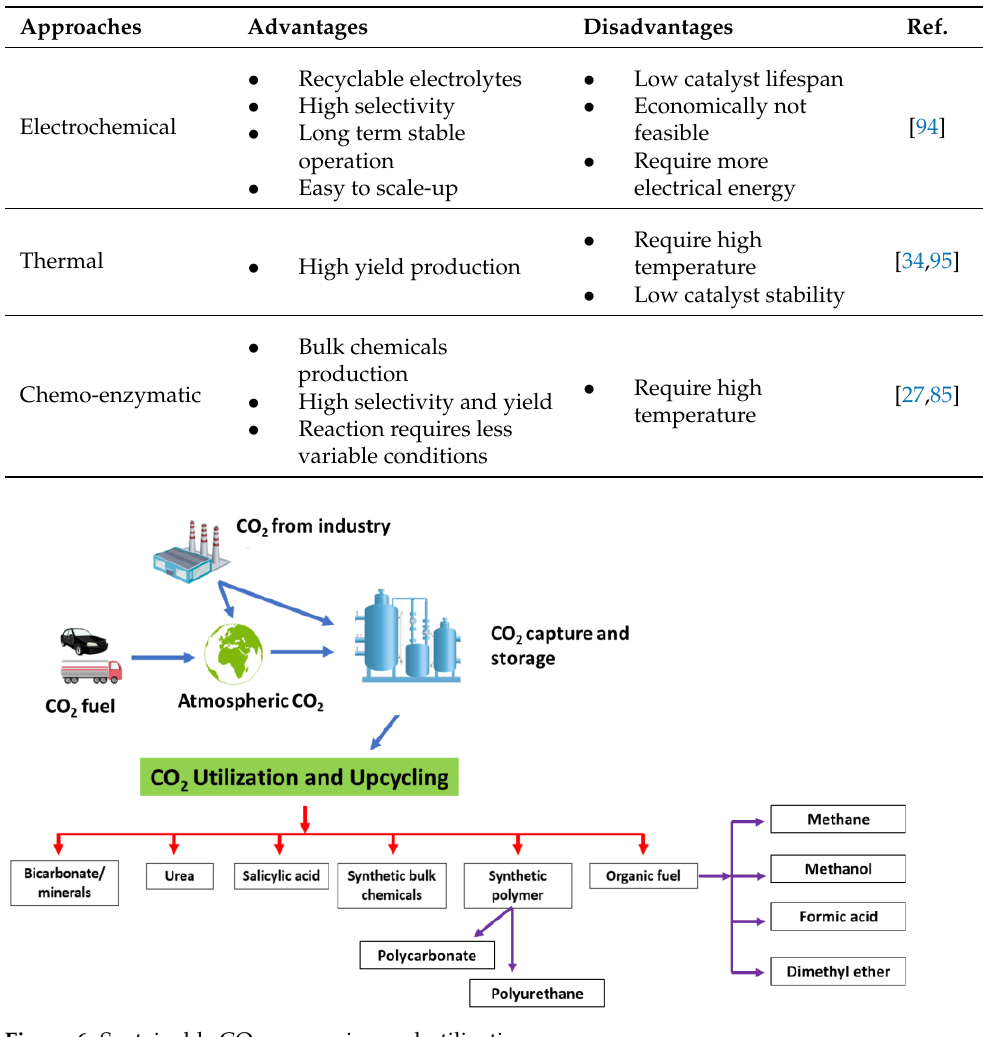
Figure 6. Sustainable CO 2 conversion and utilization .